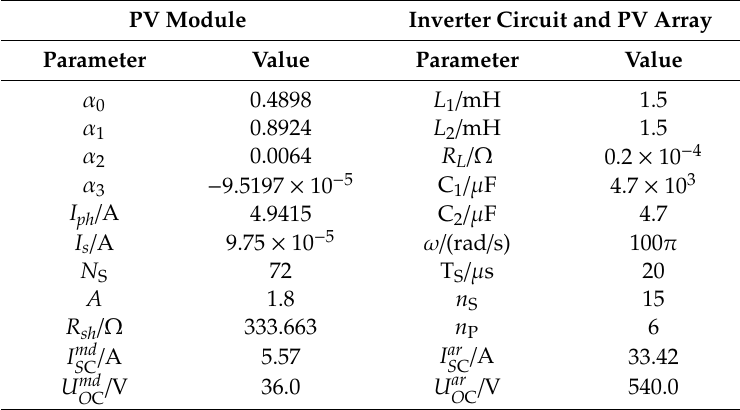
Table 1. Parameters of the photovoltaic grid-connected